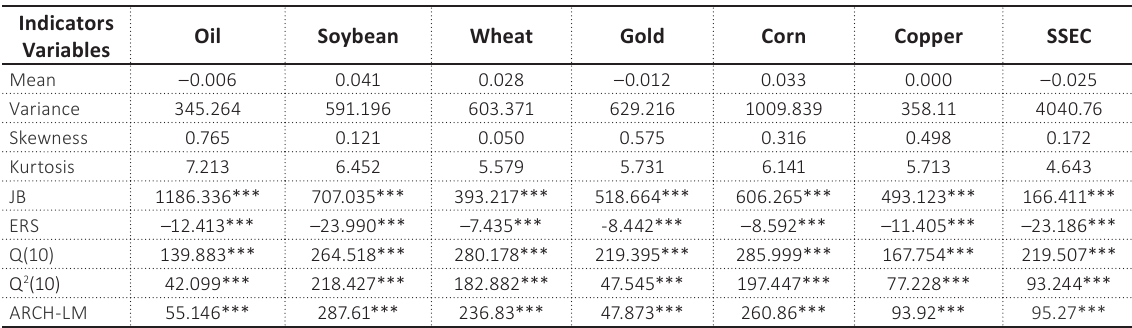
Figure 1. Time series plots of seven Table 1. Descriptive statistics